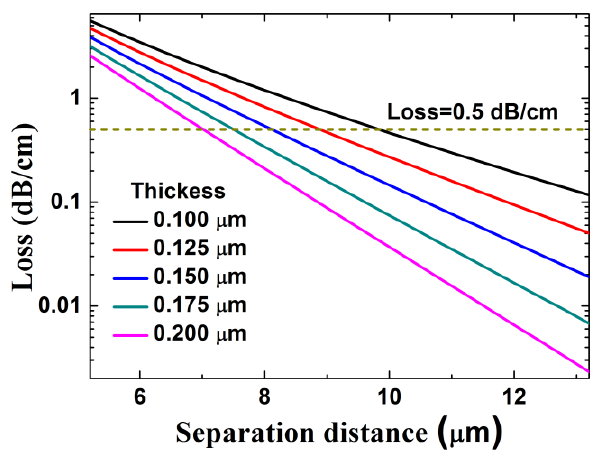
Figure 5. Relationship between the propagation loss and the separation distance.